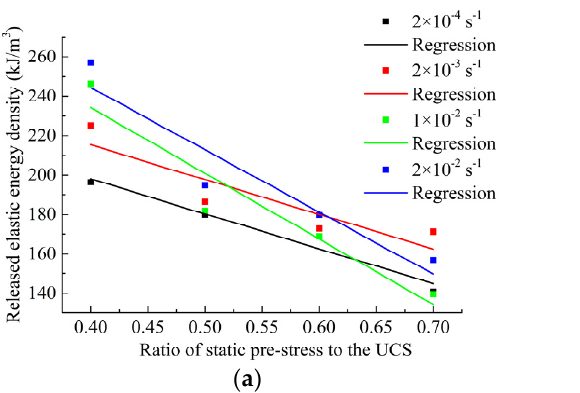
Figure 10 shows the effect of dynamic loading rate on the released elastic energy